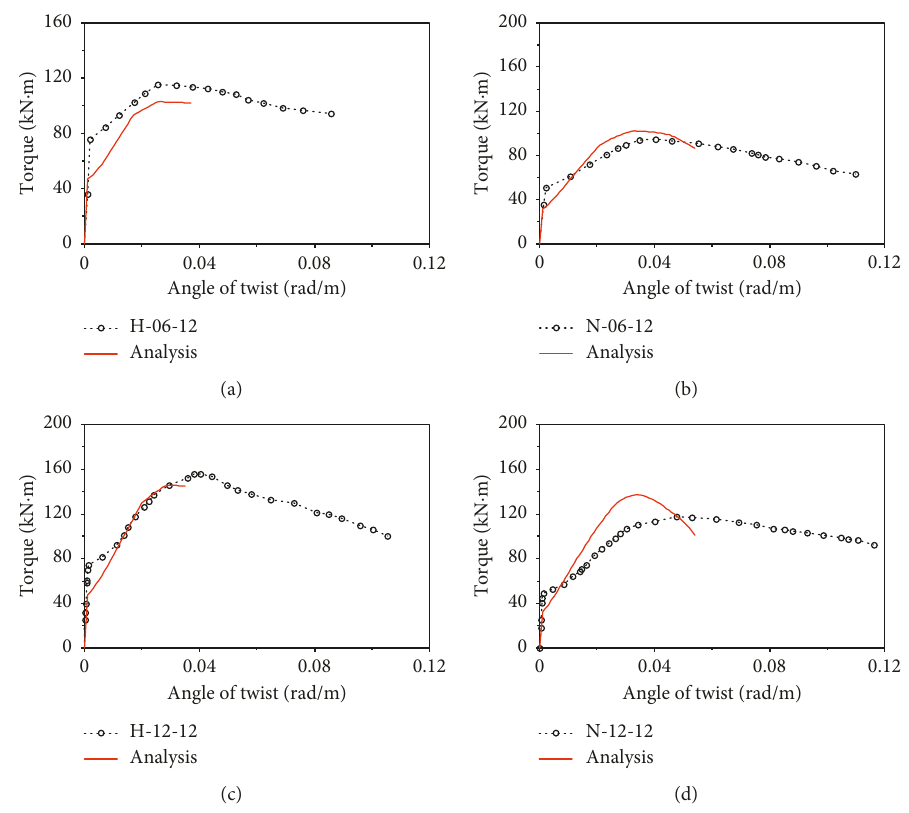
Figure 13: Analysis and test results comparison for beam 2: (a) H-06-12, (b) H-12-12, (c) N-06-12, and (d) N-12-12.